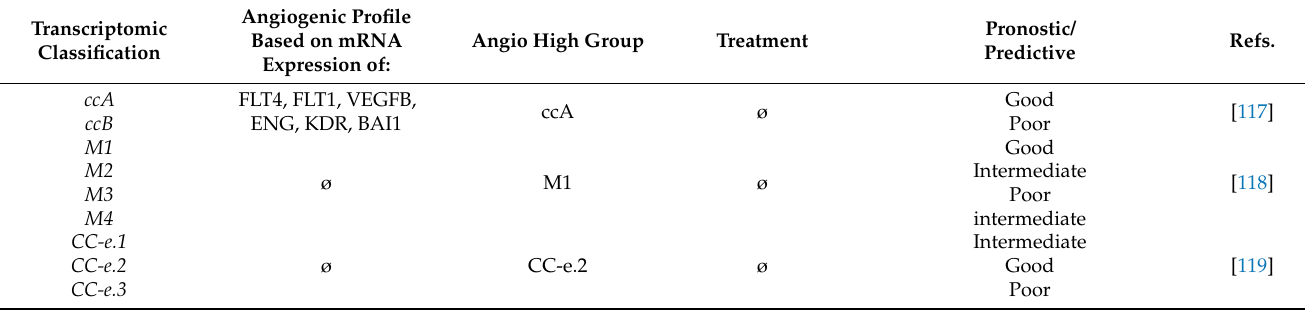
Table 1. Summary of transcriptomic data as prognostic or predictive